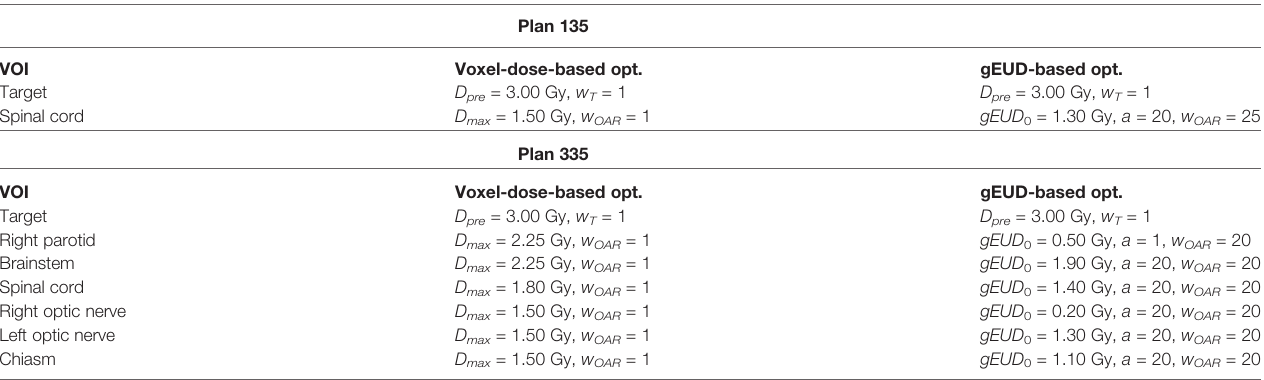
TABLE 1 | Cost function parameters for plans 135 and